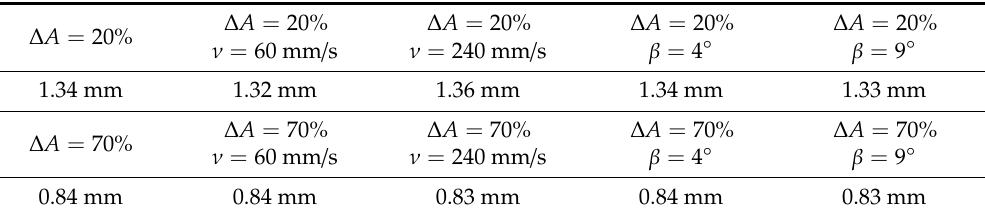
Average coating thicknesses after CWR for di ff erent process parameters in the experimental